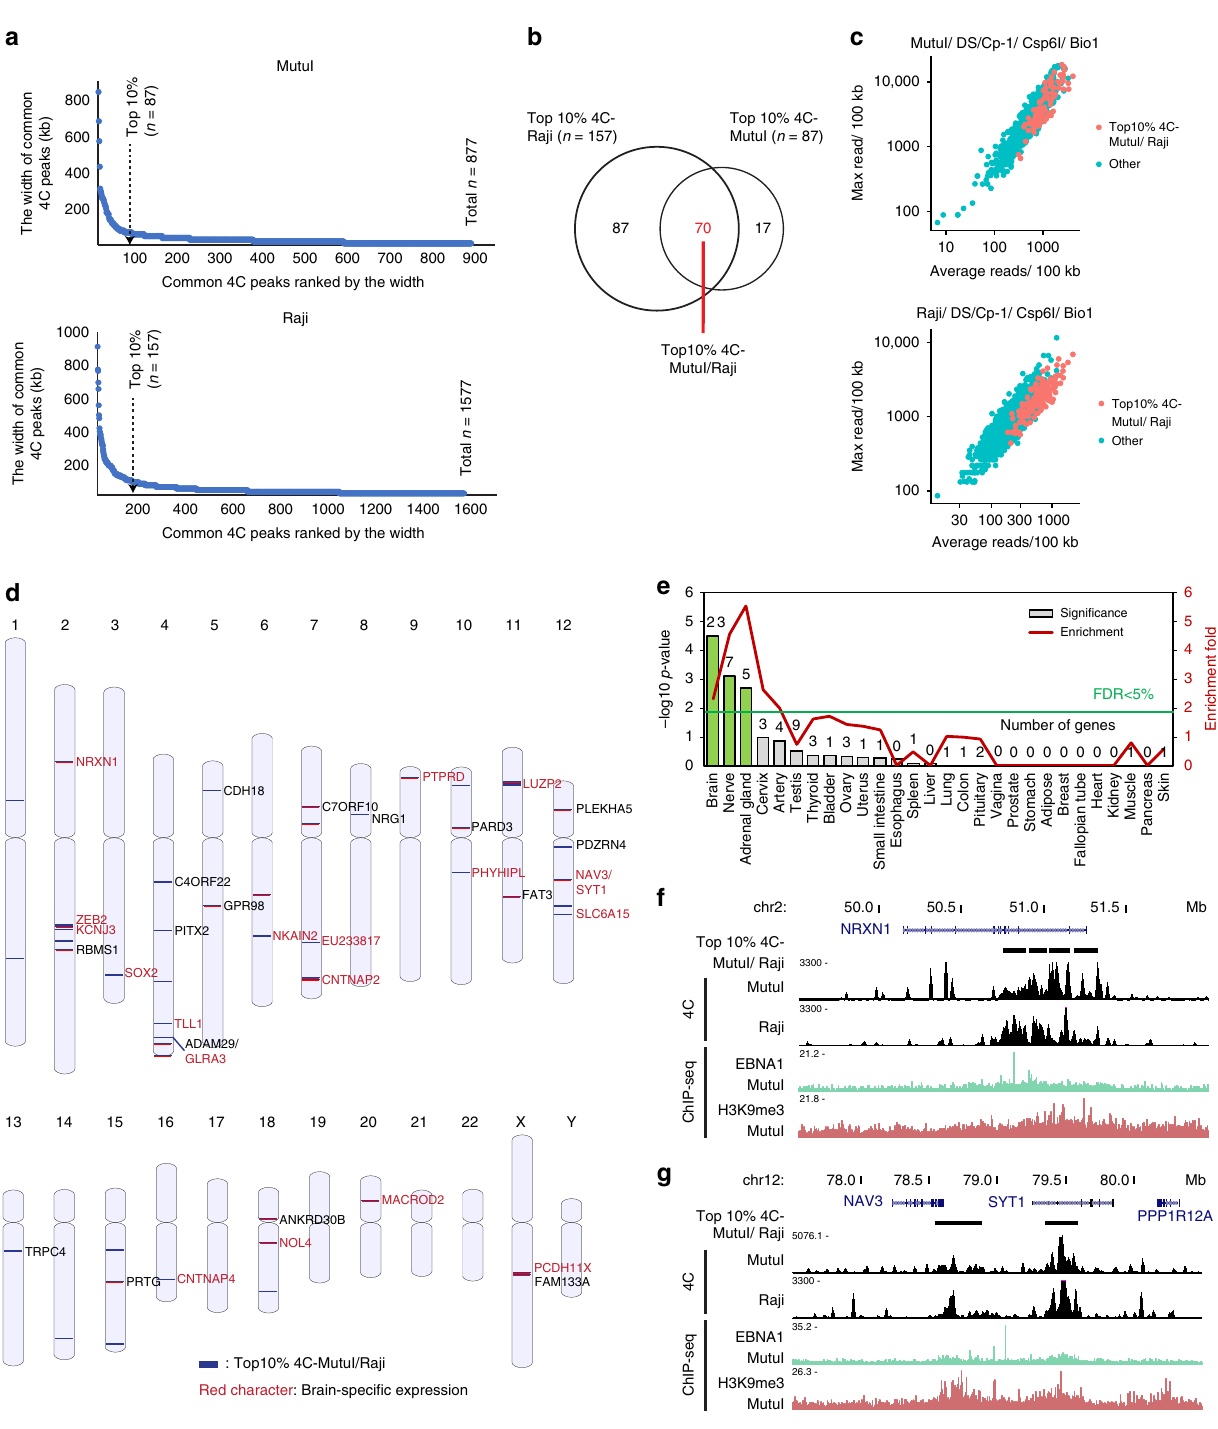
Fig. 5 High-frequency EBV tethering at transcriptionally silent neuronal genes. a Common 4C peaks ranked by the width of each peak for MutuI (top panel) and Raji (bottom panel) cells. b Venn diagram showing co-occupancy of top 10% common 4C peaks between MutuI and Raji (Top10% 4C-MutuI/ Raji). c Distribution of Top10% 4C-MutuI/Raji on the graph of average reads per 100 kb ( x -axis) and the maximum read per 100 kb ( y -axis) acquired from MutuI/DS/Cp-1/Csp6I/Bio1 (top panel) and Raji/DS/Cp-1/Csp6I/Bio1 (bottom panel). d Positions and associated genes for Top10% 4C-MutuI/Raji across chromosomes plotted using NCBI genome decoration page. e Enrichment of tissue speci fi c genes positioned in Top10% 4C- MutuI/Raji sites. f , g UCSC genome browser image showing the comparison of 4C data for MutuI and Raji with EBNA1-/H3K9me3- ChIP-seq data for MutuI along the indicated chromosome regions containing genes NRXN1 (panel f ), NAV3, and SYT1 (panel g ) speci fi cally expressed in